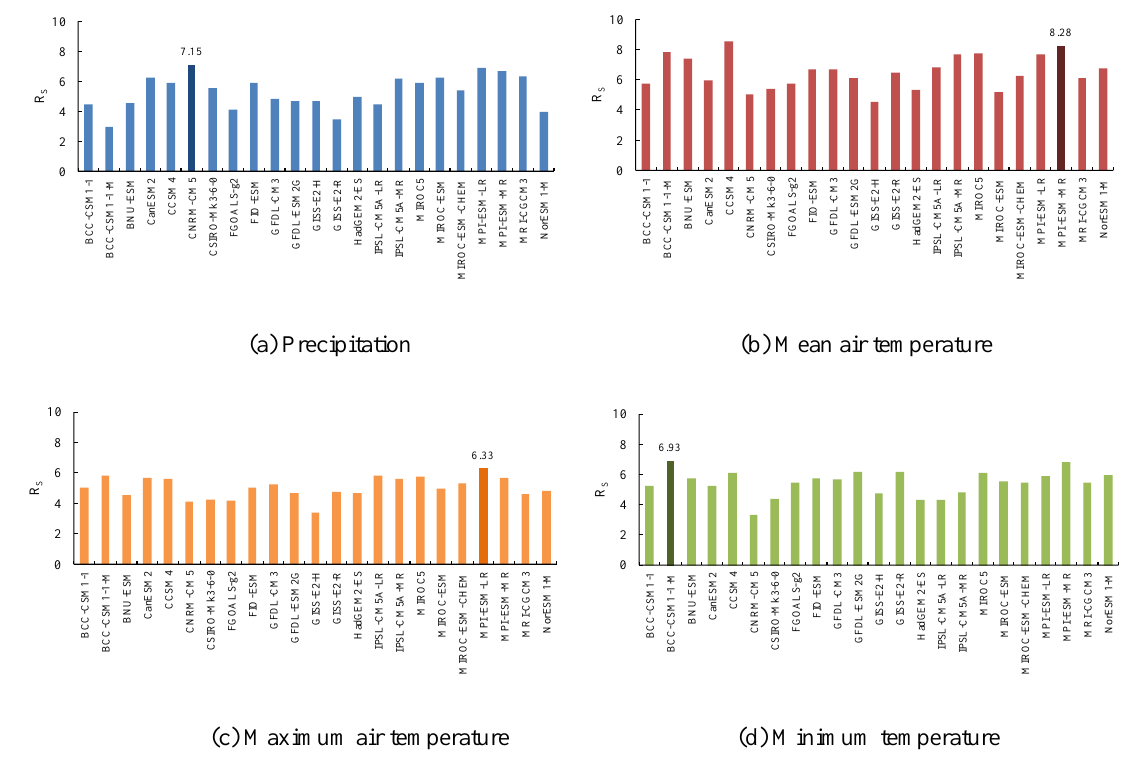
Figure 2. Results of evaluation scores from 23GCMs by rank scoring method.